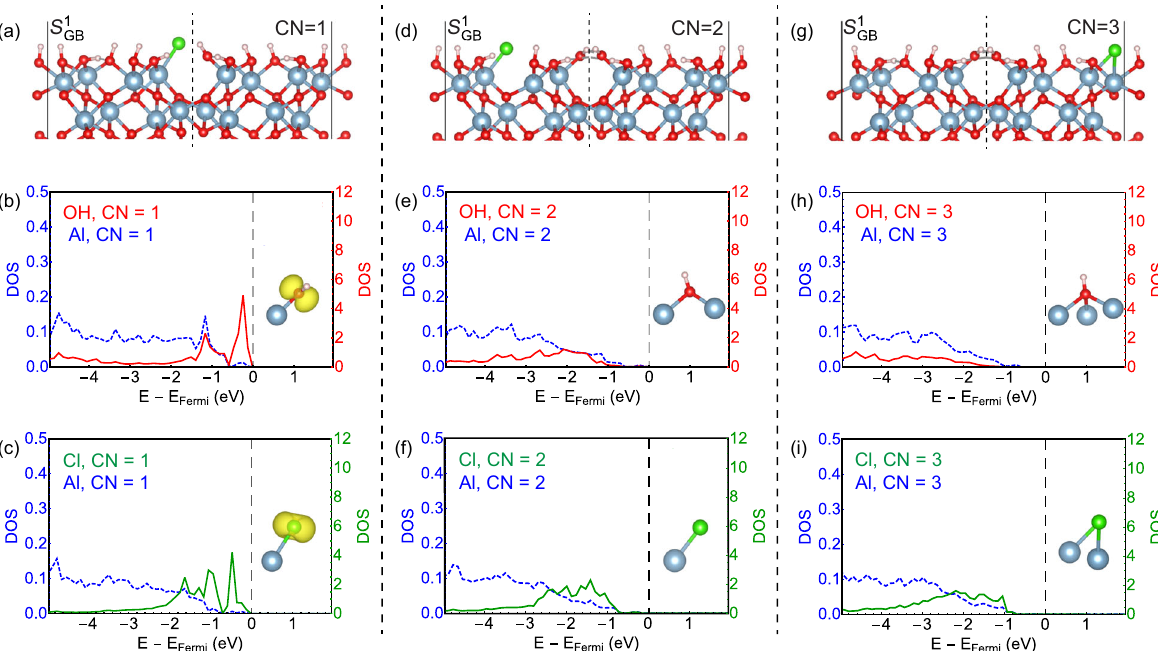
Fig. 8 Surface electronic structures for 1 Cl OH at different sites. a 1 Cl OH adsorbed at the OH site with CN = 1. For clarity, only atoms within two oxygen layers from the surface are shown. b PDOS at the CN = 1 site for the saturated surface before the Cl OH adsorption. The solid red line represents the PDOS of the OH with CN = 1. The dashed blue line represents the PDOS of the Al atom that is bonded to the OH. c PDOS at the CN = 1 site after the Cl OH adsorption. The solid green line represents the Cl atom. The dashed blue line represents the PDOS of the Al atom that is bonded to the Cl. d – f Surface con fi guration ( d ), the PDOS of Al/OH before the Cl OH adsorption ( e ), and the PDOS of Al/Cl after the Cl OH adsorption ( f ) at the site of CN = 2. g – i Surface con fi guration ( g ), the PDOS of Al/OH before the Cl OH adsorption ( h ), and the PDOS of Al/Cl after the Cl OH adsorption ( i ) at the site of CN = 3. For all PDOS plots, inset fi gures show the partial charge density of the anion species integrated over the PDOS peak just below the Fermi level (E − E Fermi ∈ [ − 1, 0]